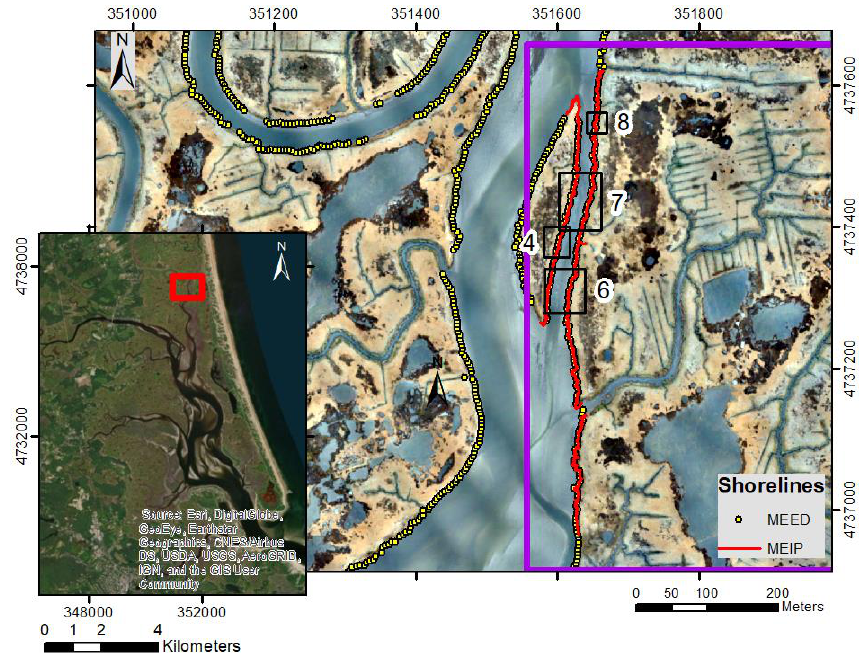
Figure 2. Plum Island Estuary, Massachusetts (MA). The shoreline calculated using the MEED method with unmanned aircraft system (UAS) data is shown with yellow dots. The unvegetated / vegetated line calculated using the marsh edge by image processing (MEIP) method with UAS data is shown as a red line. Box 4 indicates the area plotted in Figure 4. Box 6 indicates the area plotted in Figure 6. Box 7 indicates the area plotted in Figure 7. Box 8 indicates the area plotted in Figure 8. The purple line indicates the extent of the multispectral imagery used by the MEIP method. Imagery in main map is from UAS; imagery in the inset is from Esri.